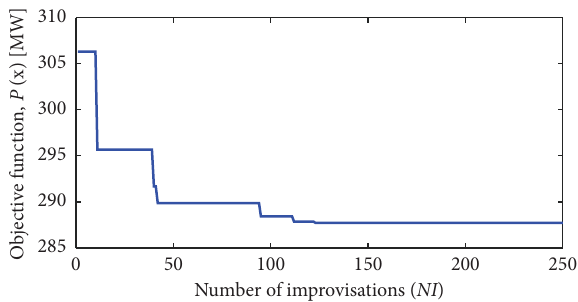
Figure 9: Convergence curve of the IHS algorithm for 250 improvisations.